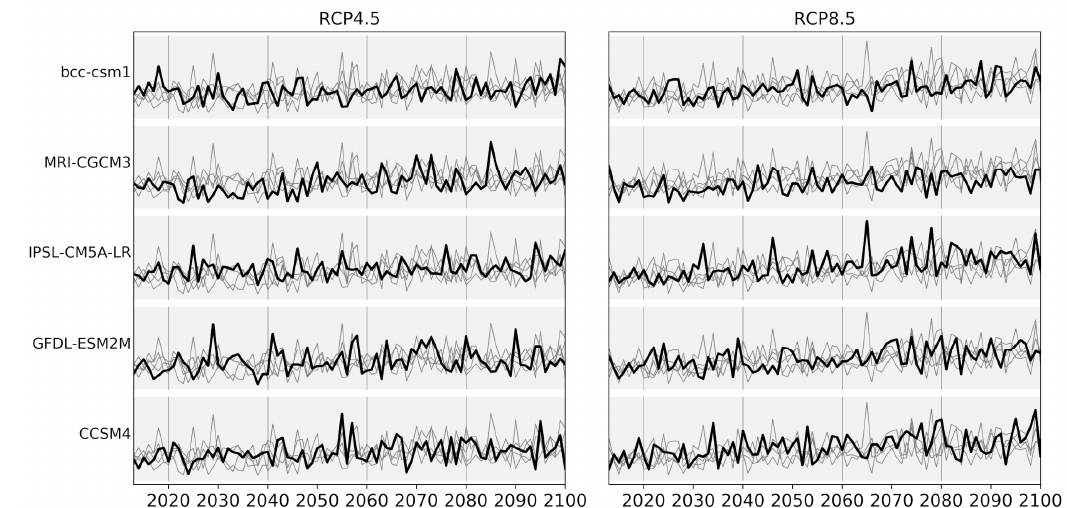
Figure 6. The projected yearly inflow of Gongguoqiao under different climate change projections.